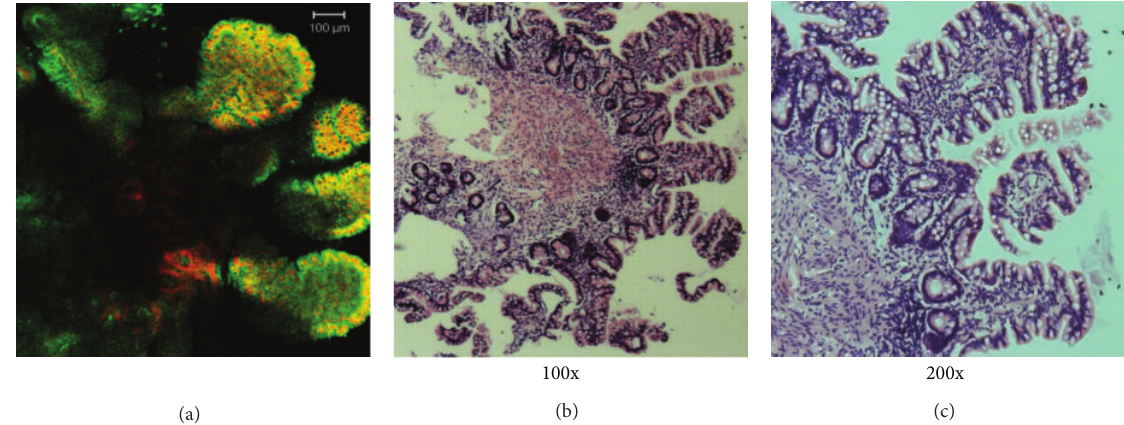
Figure 4: Reconstitution of fluorescence-stained intestinal tissues for histopathology. (a) The 3D image of the intestinal mucosa section was shown by the fluorescence staining of propidium iodide (red) for the nucleus and DiD (green) for the cell membrane. Bar:100 𝜇 m. ((b) and (c)) Histology of the intestinal tissues reconstituted from fluorescence staining (H & E staining, (b) 100x, (c) 200x ).